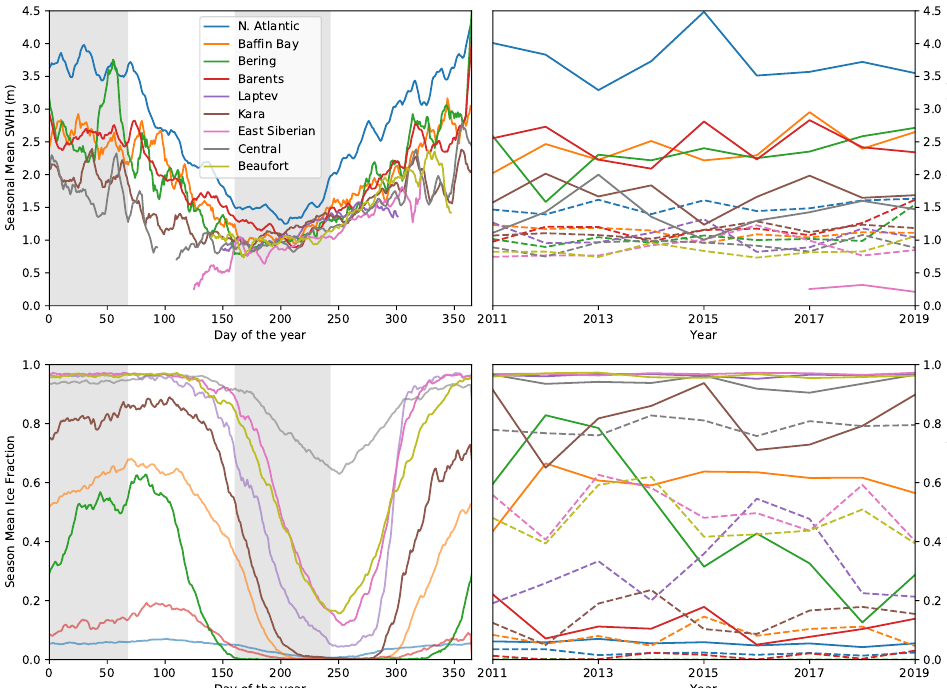
Figure 10. Seasonal cycle ( left ) and interannual variability ( right ) of SWH (m) and ice concentration for the regions indicated in Figure 9a. The interanual variability is for the days 01-01 to 03-10 (solid lines) and days 06-10 to 08-30 (dashed lines) periods shown by the grey bands on the seasonal cycle.